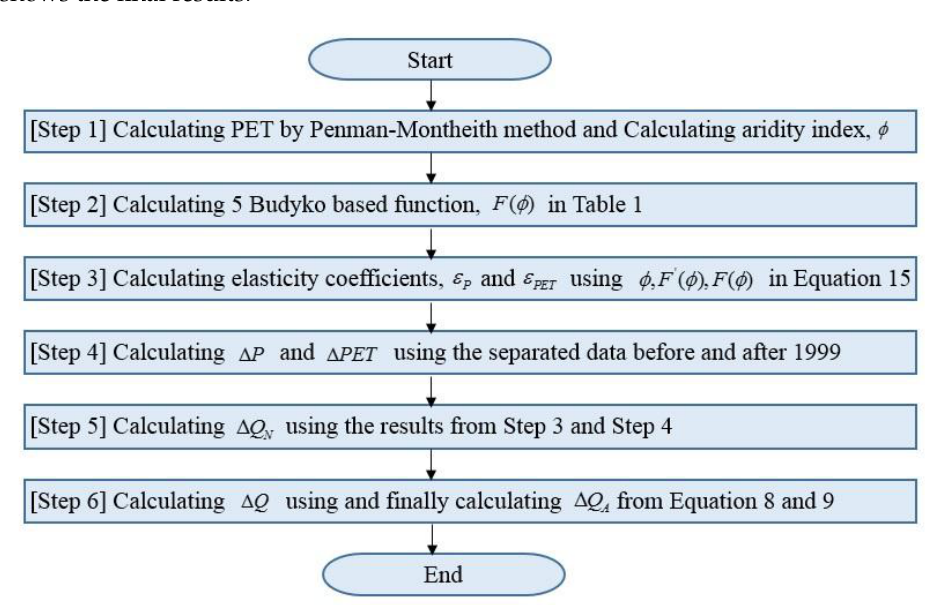
Figure 6. Flow chart for calculating the inflow variation by two factors. PET : potential evapotranspiration. Table 5. Results of the hydrological sensitivity method.